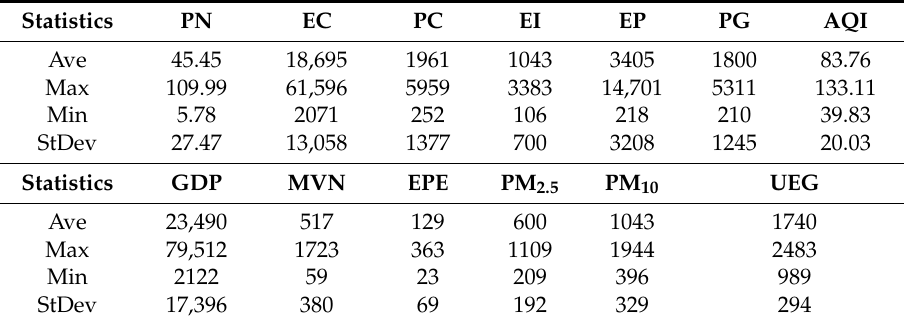
Table 3. Descriptive statistics of input and output variables in